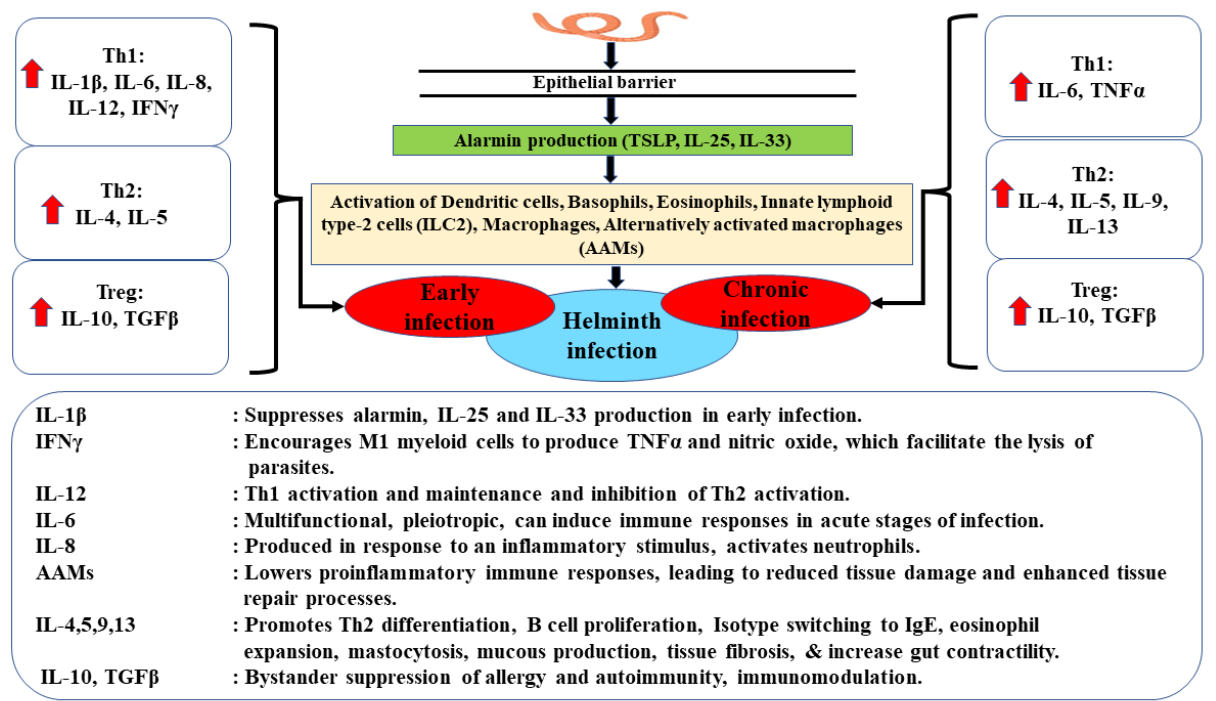
Figure 2. Immune response profiles during helminth infection. Migration of helminths damages epithelial barrier cells and tissues, triggering an immune response. Helminths produce damage and pathogen-associated molecular patterns (DAMPS and PAMPS). DAMPS and PAMPS activate various cells, such as epithelial, which release alarmins such as Thymic stromal lymphopoietin (TSLP), IL-25 and IL-33. Alarmins stimulate innate lymphoid cells (ILCs), aiding collagen deposition and tissue repair, and are a source of IL-5 required for eosinophil activation. Eosinophils enter tissues during helminth infection-induced inflammation. Eosinophilia is a crucial feature of the host response to helminth infection. Alarmins promote B cell activation and induction of alternatively activated macrophages (AAMs). AAMs stimulate IL-10 and TGF- β , which reduce the host’s immune response to pathogens to avoid damaging the host and maintain normal tissue homeostasis. Classically activated macrophages, stimulated by IFN- γ produce proinflammatory cytokines (IL-1 β , IL-6, IL-8, IL-12 and TNF- α ). Figure 2 Footnotes: IL: interleukin; IFN- γ : interferon-gamma; TGF β : transforming growth factor beta; TNFα: tumor necrosis factor-alpha; ILCs: innate lymphoid cells; TSLP: Thymic stromal lymphopoietin; AAMs: alternatively activated macrophages; DAMPS: damage-associated molecular patterns; PAMPS: pathogen-associated molecular patterns. Red arrow pointing up indicates cytokines that are upregulated/increased during the early stages of helminth infection and those that are upregulated during the chronic stages.